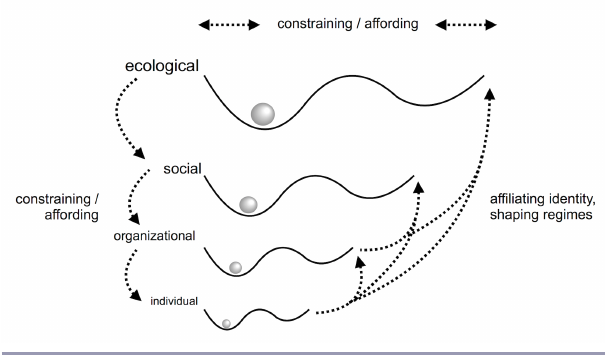
Fig. 1 . A scalar model of purposeful change